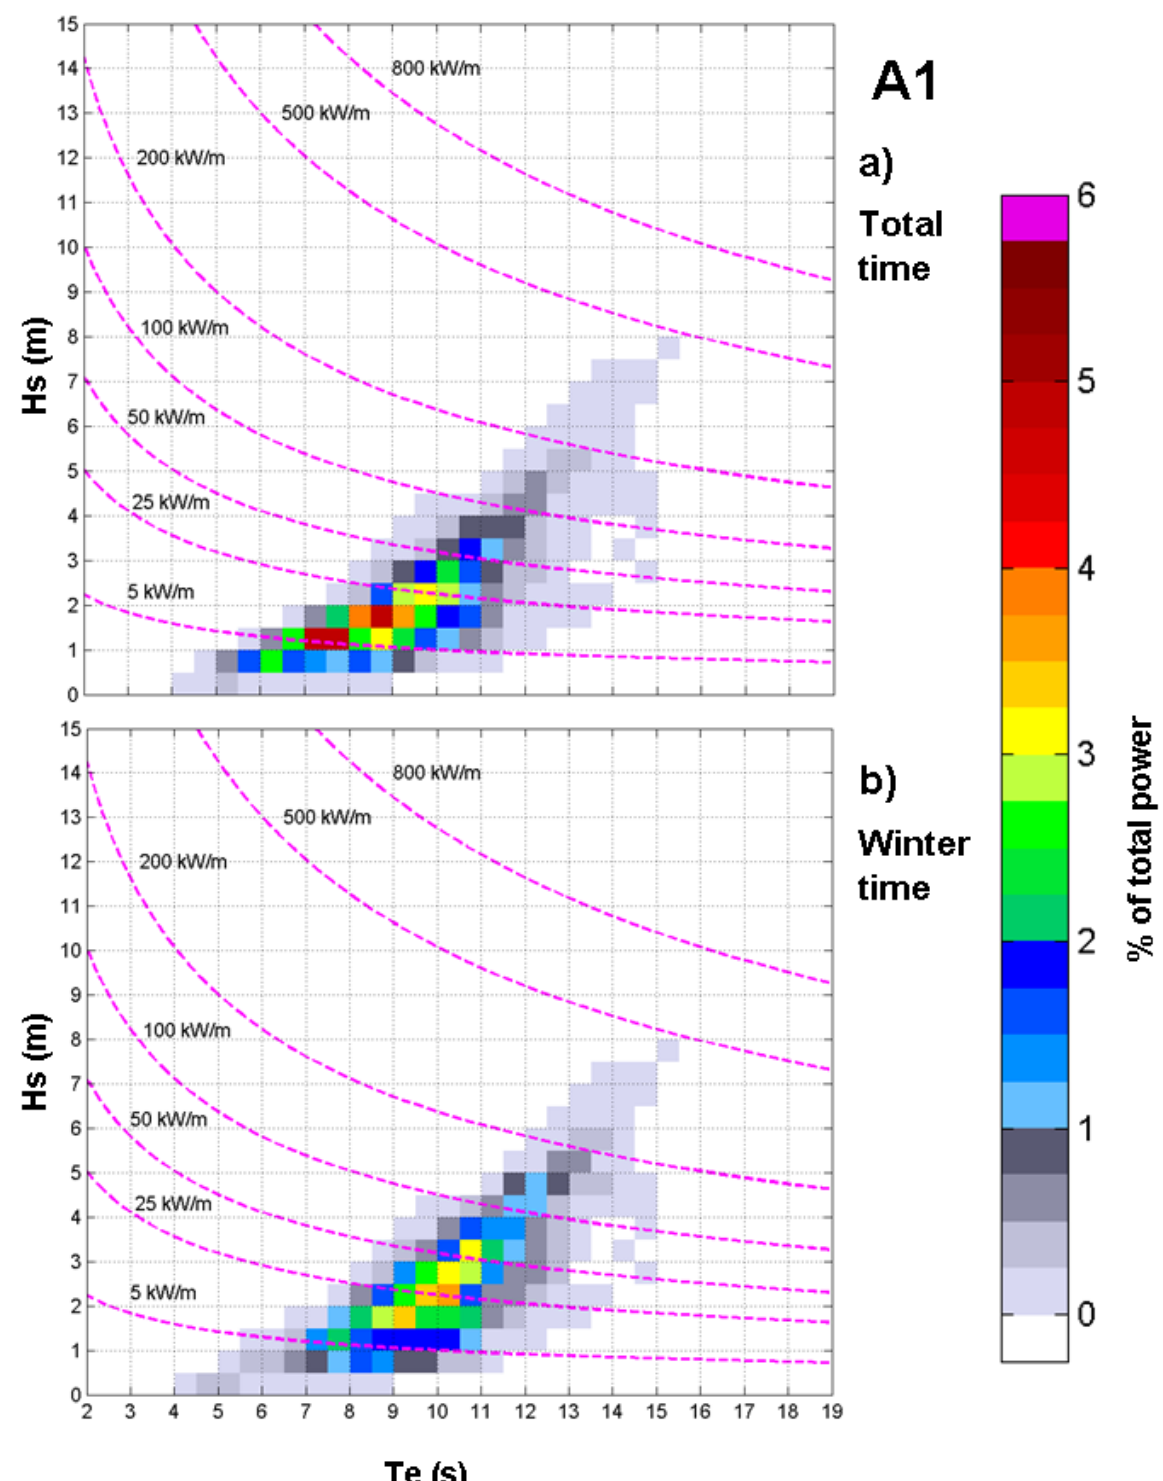
Figure 2. Reference point A1 (P5 offshore); bivariate distributions of occurrences corresponding to the sea states defined by H 2009–2011. The color scale is used to represent the contribution of the sea state to the total incident energy, as a percentage. The wave power isolines are also represented. ( a ) Total time; ( b ) Winter